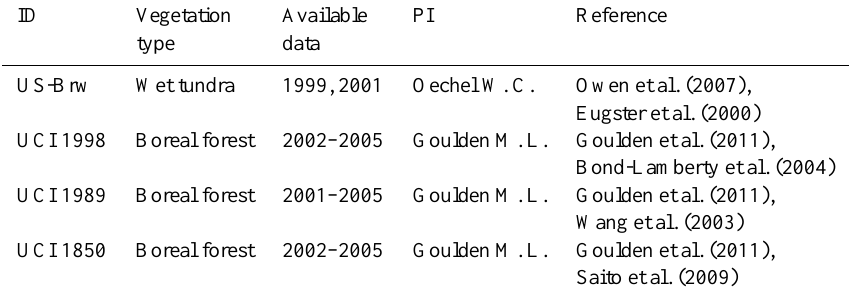
Table 1. Information of AmeriFlux sites used in the study.